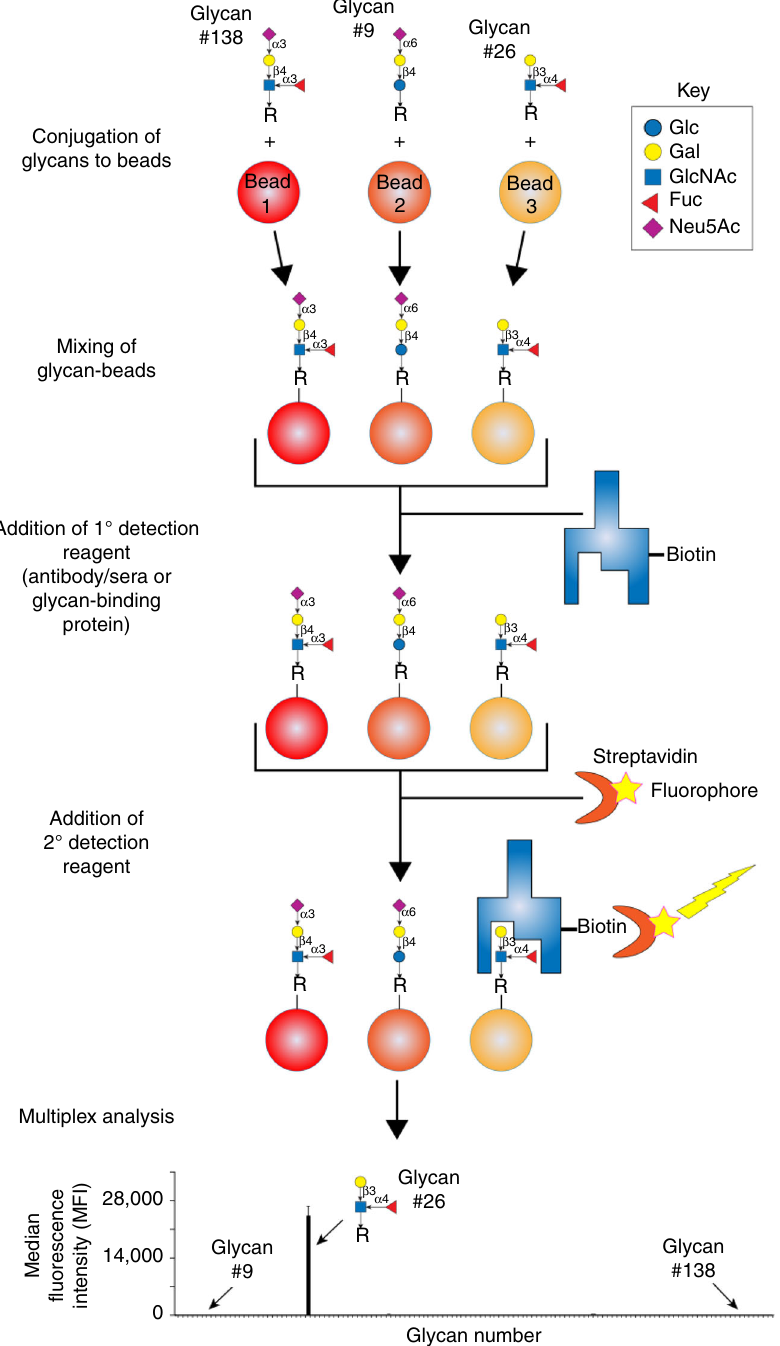
Fig. 1 Design and work fl ow of MGBA. Each glycan was conjugated to one region speci fi c Luminex bead, using 1-ethyl-3-(3-dimethylaminopropyl) carbodiimide hydrochloride. After blocking the beads with 1% BSA in PBS (w/v), the beads were probed with biotinylated lectins, anti-glycan antibodies and glycan-binding proteins. After washing, the bound lectins, anti-glycan antibodies and glycan-binding proteins were detected using phycoerythrin labelled streptavidin (SAPE). The unbound SAPE was removed by washing, and beads were resuspended in wash buffer. The beads were read in FLEXMAP 3D, as per settings de fi ned in “ Methods ” secrion. The median fl uorescence intensity data is then presented as mean+standard deviation of two replicates; each experiment was repeated three